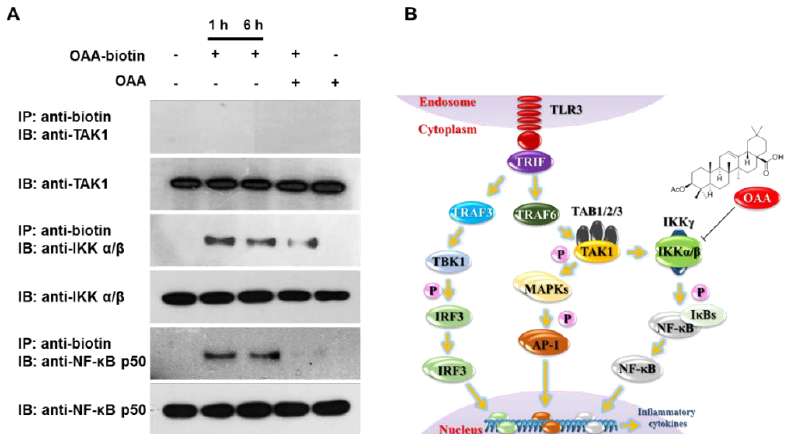
Figure 4. OAA targets IKK α / β . Cell lysates were treated with biotin-OAA or OAA for 1 or 6 h at a concentration of 30 µ M, and the lysates were then subjected to pull-down experiments using streptavidin agarose beads. ( A ) The precipitates were analyzed by immunoblotting with the indicated antibodies. ( B ) Proposed model of OAA anti-inflammatory activity in poly(I)-induced TLR3 signaling.